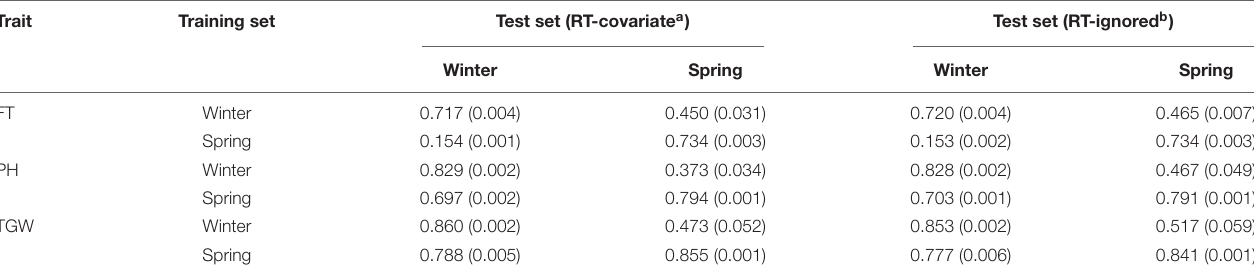
TABLE 5 | Genome-wide prediction abilities of flowering time (FT), plant height (PH), and thousand grain weight (TGW) within and across growth habit populations for the entire barley accessions.